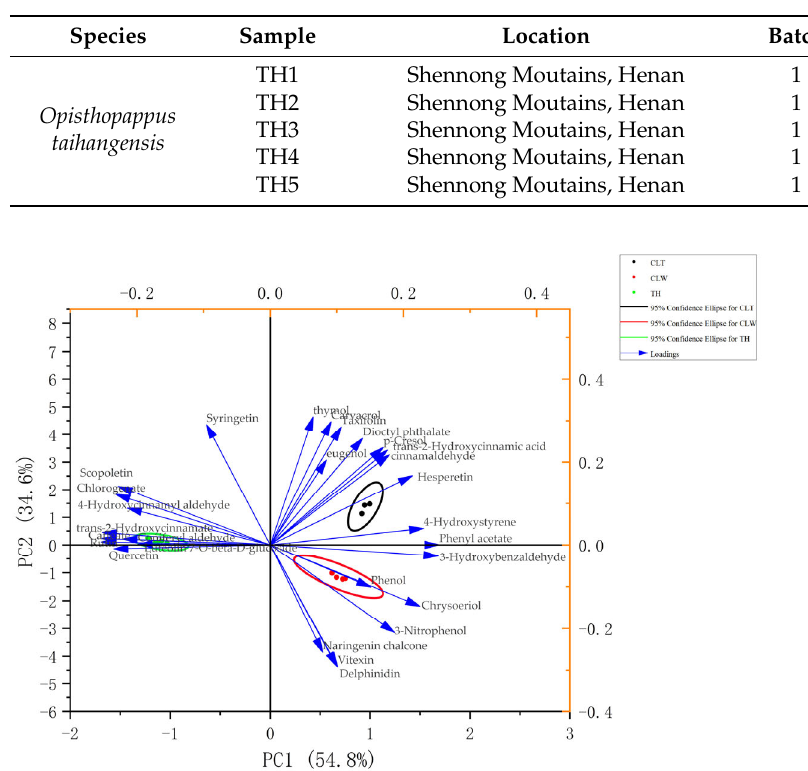
Figure A1. PCA of significant aromatic substances of CLT, CLW, TH groups. Note: The arrows indicate the feature vectors of the aromatic metabolites. The projection of the arrows to the coordinate axis represents the contribution of the original feature to each principal component in the new space. The longer the projection, the greater the contribution of this metabolite to this principal component. Based on the feature vectors of metabolites, it can be clearly seen that the samples from different groups were far apart from each other, while samples from the same group were gathered together. In addition, the black, red, and green dots represent samples from the CLT, CLW, and TH groups, respectively.